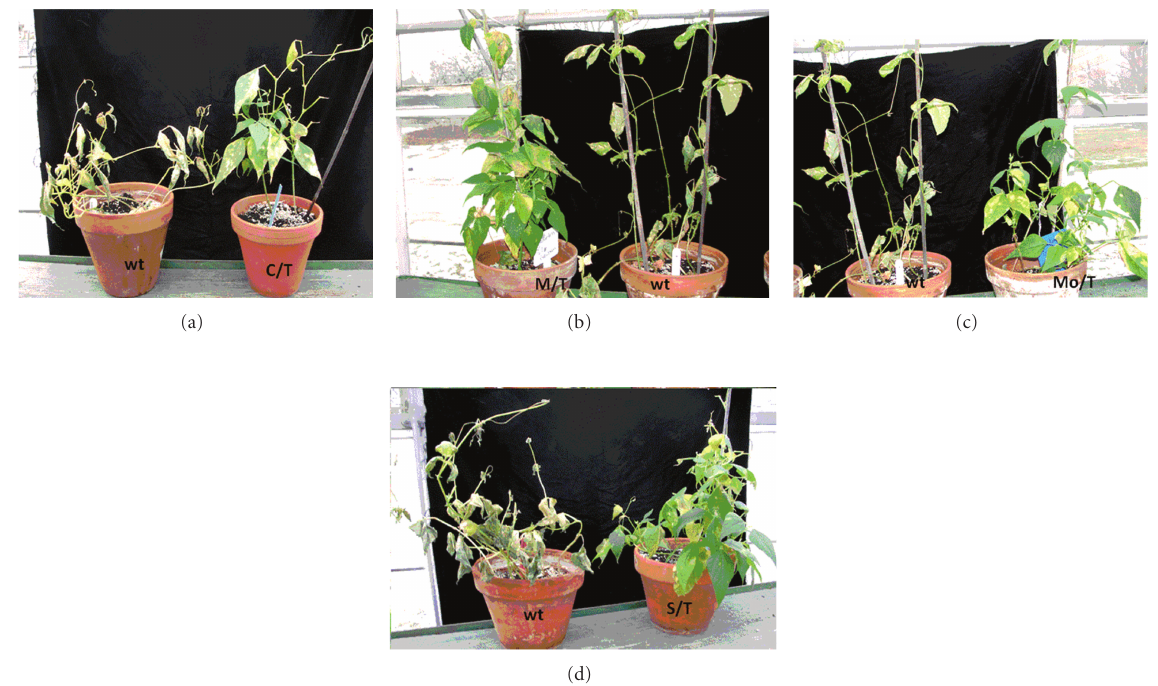
Figure 5: Although not completely resistant, the trifoliate stage of the third generation transgenic (T2) plants that had transcribed bar gene showed more resistance to foliar spray of 150 mgL − 1 Liberty herbicide than their wild-type control non-transgenic counterpart plants. “Condor” (a), “Matterhorn” (b), “Montcalm” (c), and “Sedona” (d). “Matterhorn” seems to be more resistant to the herbicide.